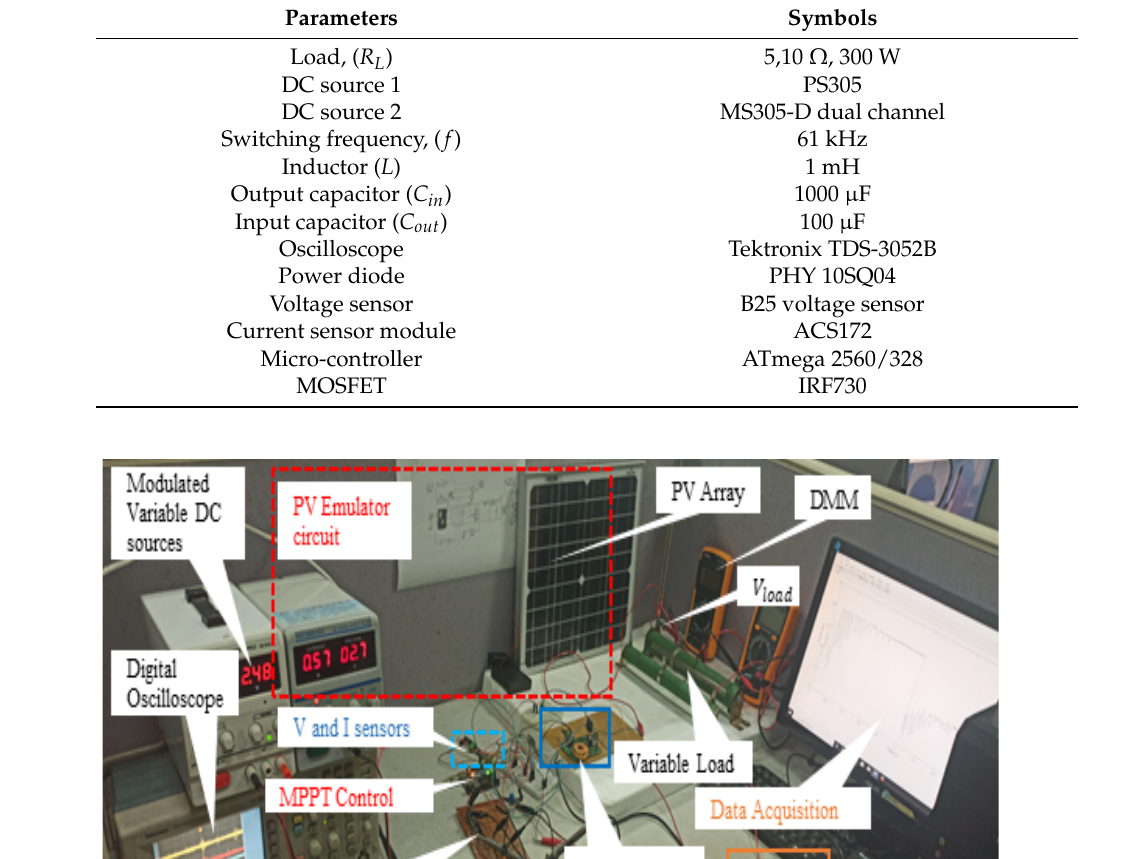
Table 7. Specifications of hardware components.